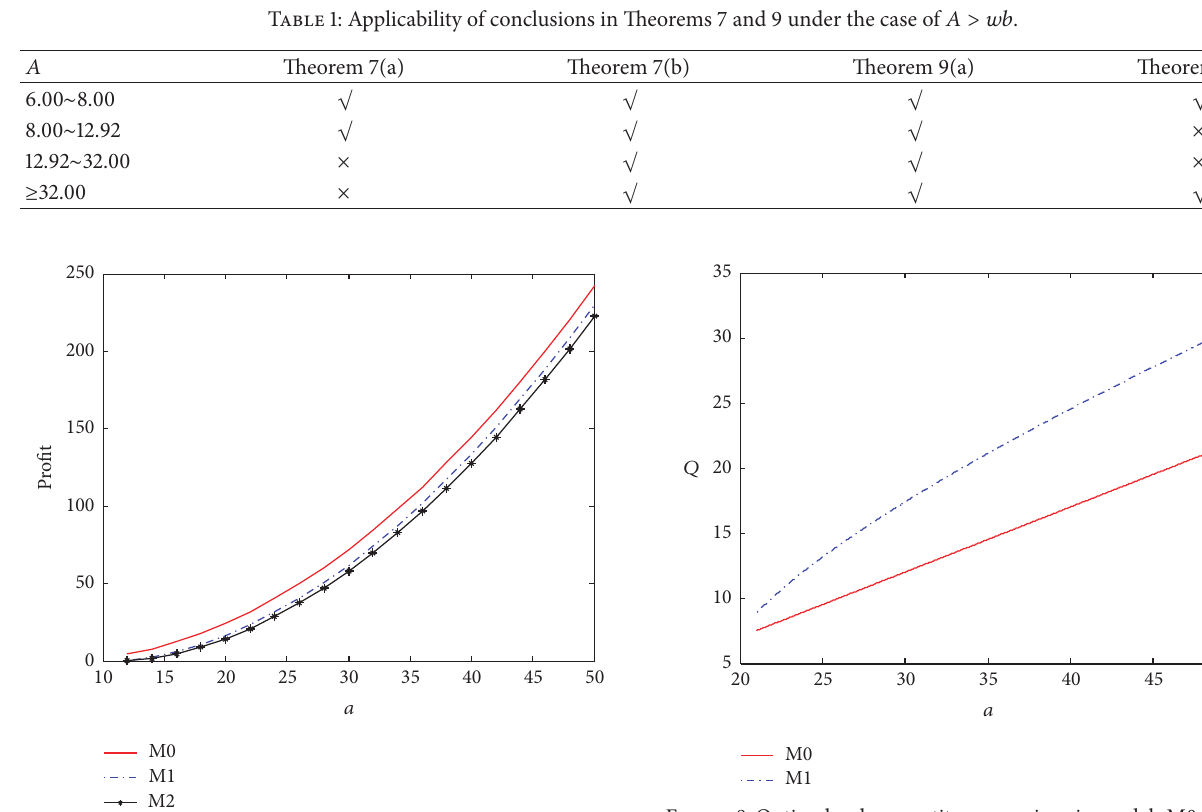
Figure8: Optimal orderquantity comparisonin modelsM0and M1 ( 𝐴 = 15